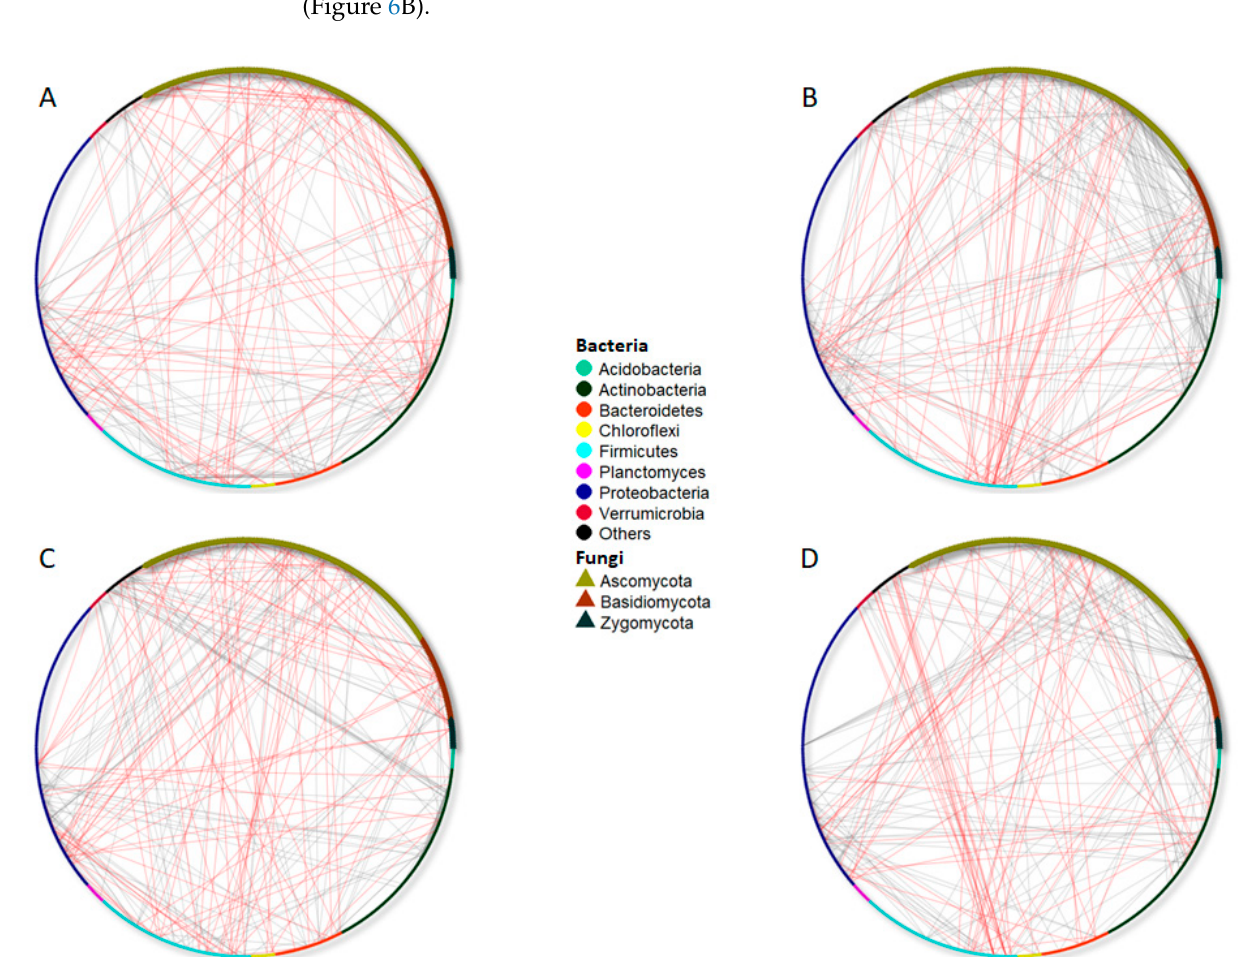
Figure 6. Significant co-occurrence networks of bulk soil bacterial and fungal communities living in the fully irrigated (FI, ( A ), half irrigated (HI, ( B ), non-inoculated (NI) ( C ), or inoculated with AMF (I) ( D ) plots. The nodes of each network are colored and shaped according to phylum affiliation. The edges connecting the nodes show the negative (indicated with red lines) and positive (indicated with grey lines) associations between each species.